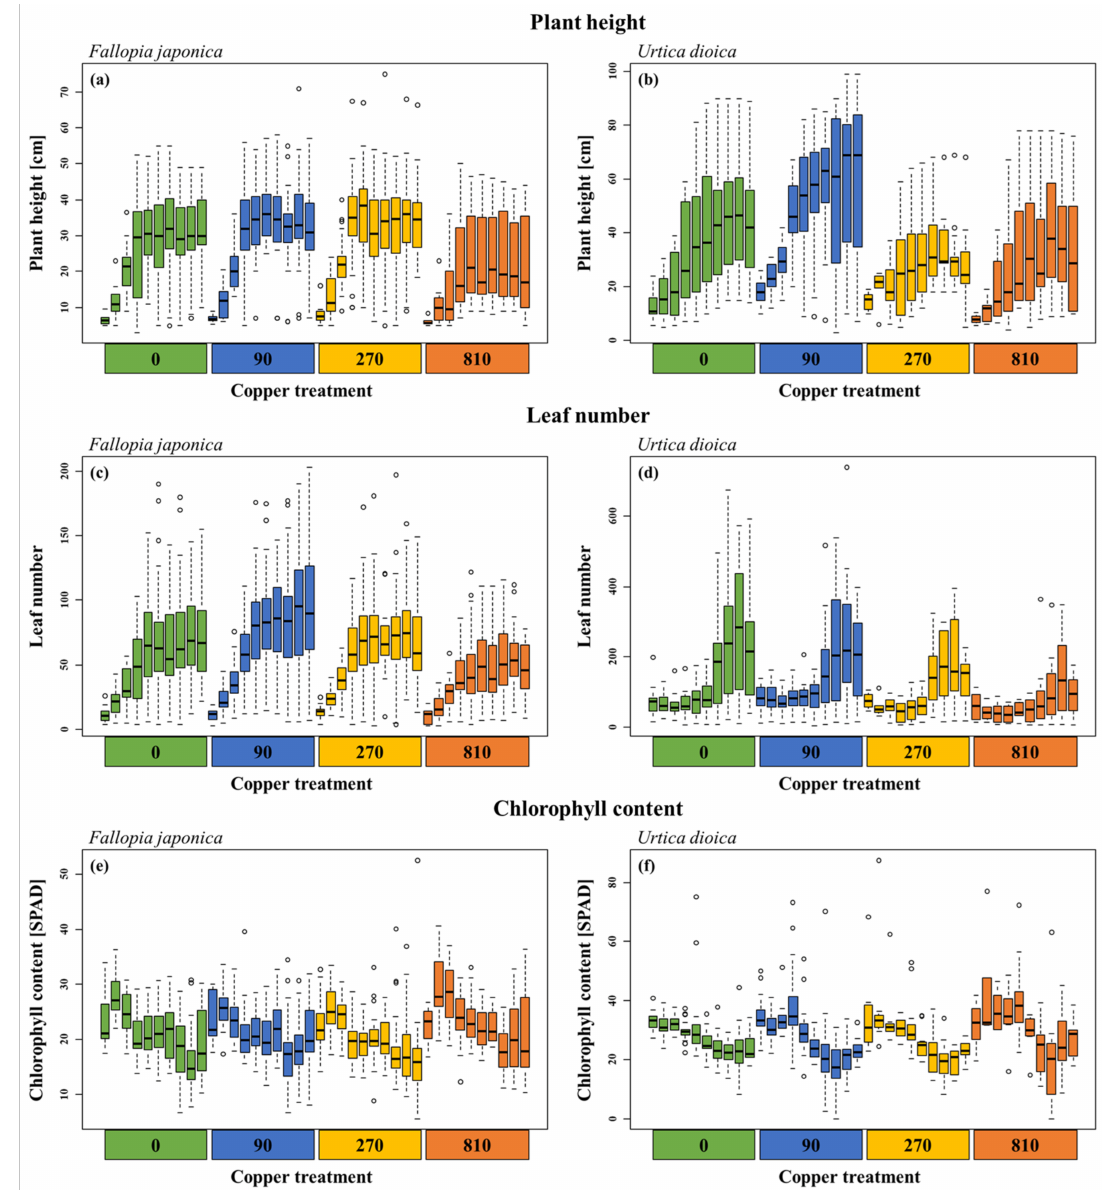
Figure 1. Plant growth parameters of Fallopia japonica and Urtica dioica recorded bi-weekly across the growing season (n = 10 time points). Shown are boxplots with median values represented by the black line. Each color represents one copper treatment from control to 810 mg kg − 1 . Within each treatment, the time in the season is shown from left to right. ( a ) Plant height of Fallopia japonica , ( b ) plant height of Urtica dioica , ( c ) leaf number of Fallopia japonica , ( d ) leaf number of Urtica dioica , ( e ) chlorophyll content of Fallopia japonica , ( f ) chlorophyll content of Urtica dioica